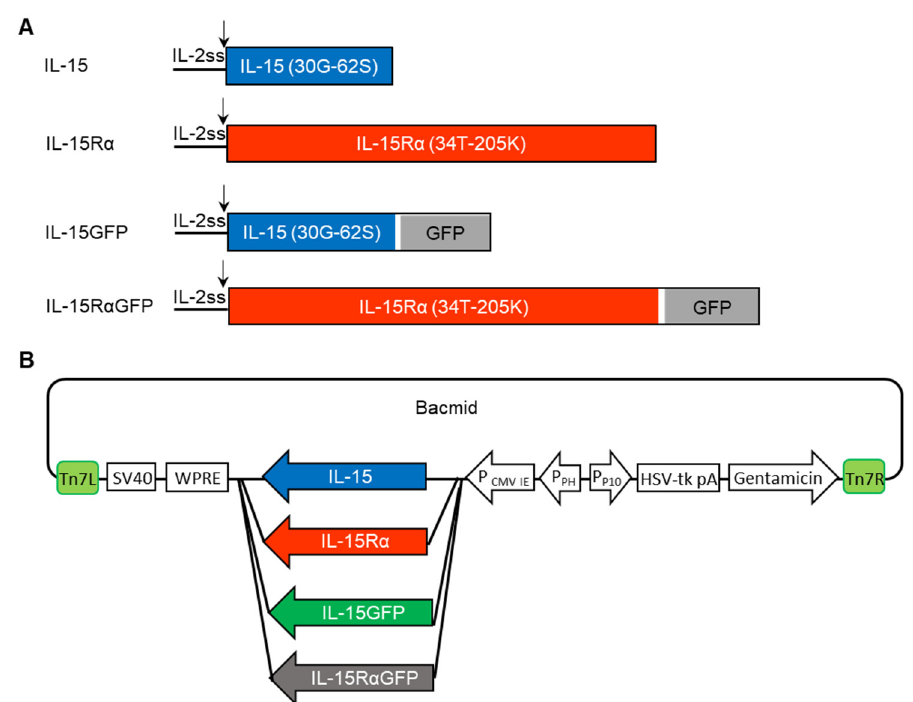
Figure 1. Construction of four different recombinant BacMam viruses (BV). ( A ) Schematic diagram of IL-15, IL-15R α , IL-15GFP, and IL-15R α GFP proteins. To make the self-assembling IL-15:IL-15R α complex, the IL-2 signal sequence (IL-2ss, 1M-20S) was used. In the IL-15GFP and IL-15R α GFP fu- sion proteins, a linker (white) was added. ( B ) Four different bacmids were generated, each of which incorporated a transgene coding sequence (IL-15, IL-15R α , IL-15GFP, IL-15R α GFP). Some elements are important for high-level expression of the transgene: P CMV ; CMV promoter, SV40; transcription termination, WPRE; mRNA processing motif. Others are important for baculovirus amplification: P PH ; promoter of polh, P P10 ; promoter of P10, HSV-tk; terminator, Tn7L and Tn7R; transposon ele- ments, gentamicin; resistance markers.